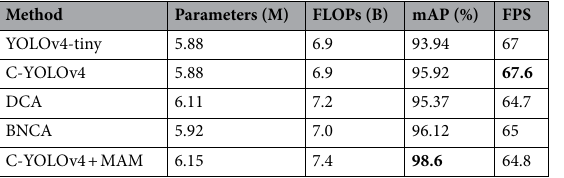
Table 3. Evaluation results on the test set. Maximum values are in bold.